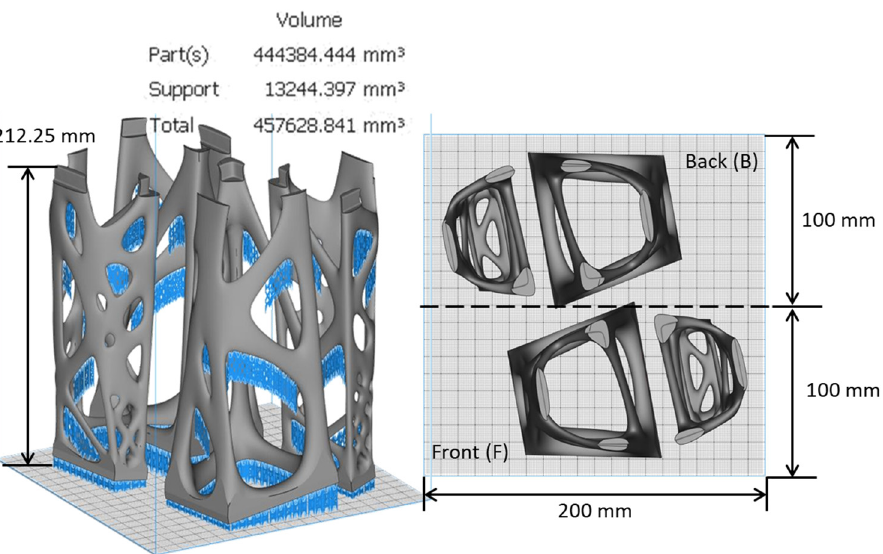
Figure 5. Macro-scale tapered box beam experiment: build support strategy and build volume layout identifying the front and back specimen locations. The experimental specimens are colored gray, while support features are shown in blue.